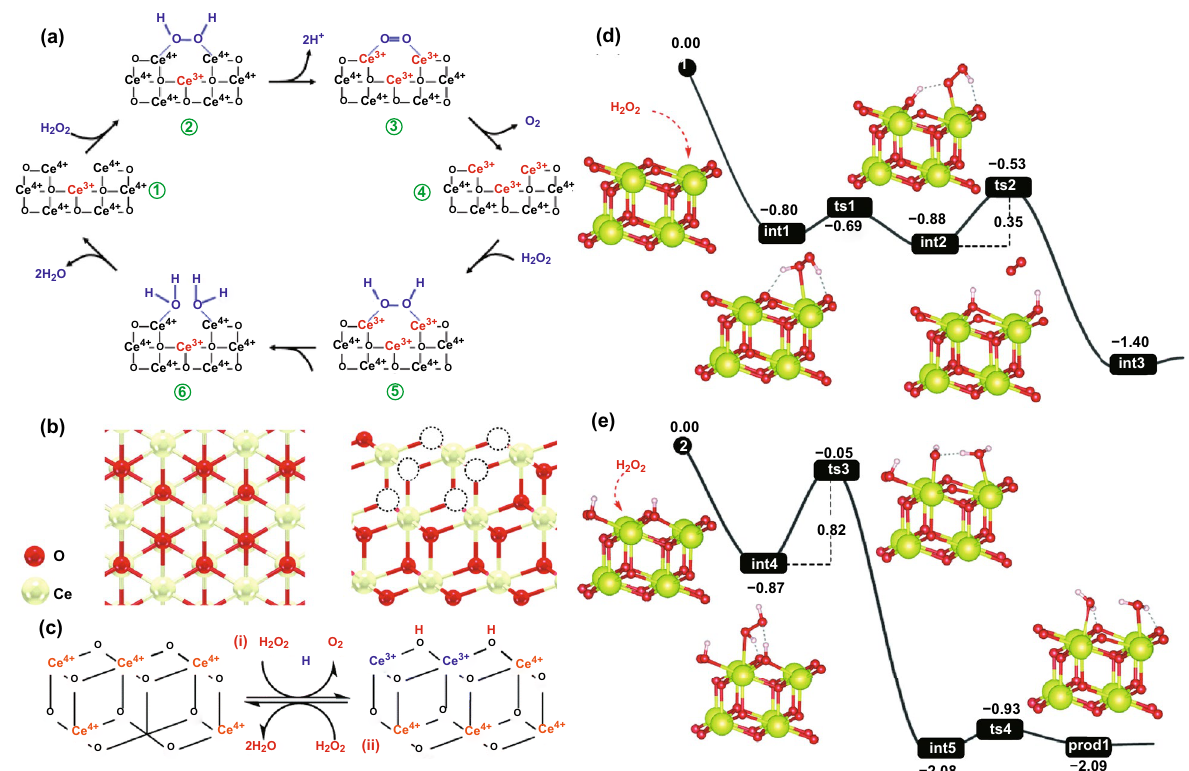
Fig. 2 a Electron transfer mechanism for the CAT-mimetic activity of CeO 2 NPs. b Top view (left) and side view (right) of the CeO 2 (111) structural model. c Atomistic-level catalytic mechanisms for the CAT-mimicking reactions of nanoceria. d , e Energy profiles for steps (1) and (2) for CeO 2 (111). Adapted from a Ref. [168], b – e [171] with